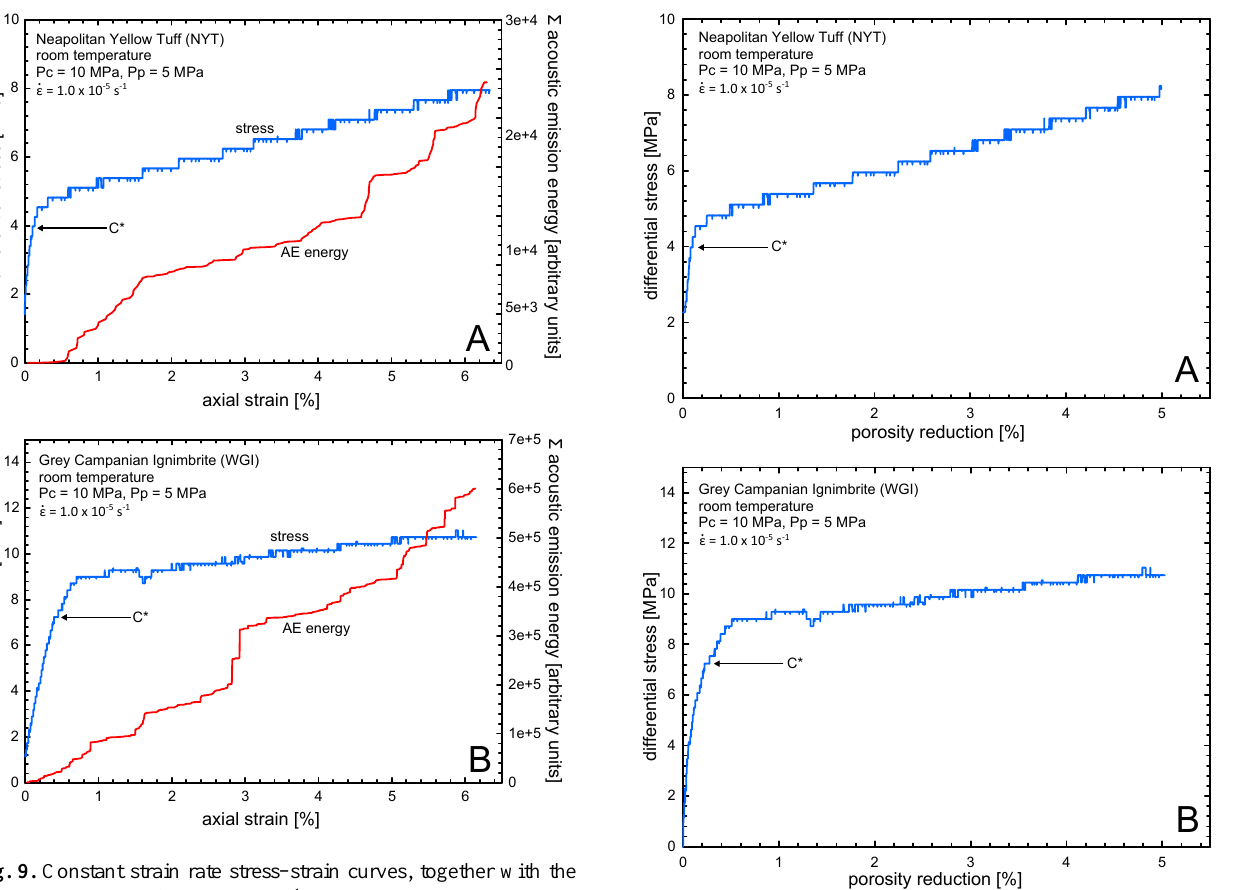
Fig. 9. Constant strain rate stress–strain curves, together with the cumulative output of AE “energy” (the area under the received AE waveform envelope) for as-collected Neapolitan Yellow Tuff (A) and Grey Campanian Ignimbrite (B) . The experimental conditions are provided on each panel and the positions of C ∗ are indicated by the arrows. The steps in the data are due to the stepwise nature of the pumps.